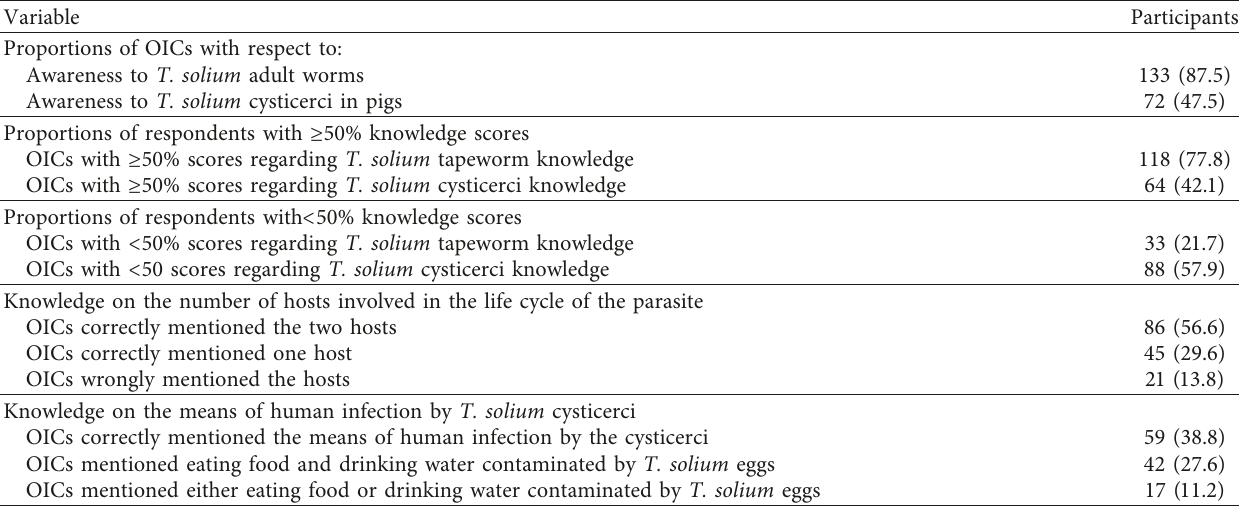
Table 2: Knowledge of officers in charge of primary healthcare facilities on T. solium tapeworm and T. solium cysticerci. Variable Proportions of OICs with respect to: